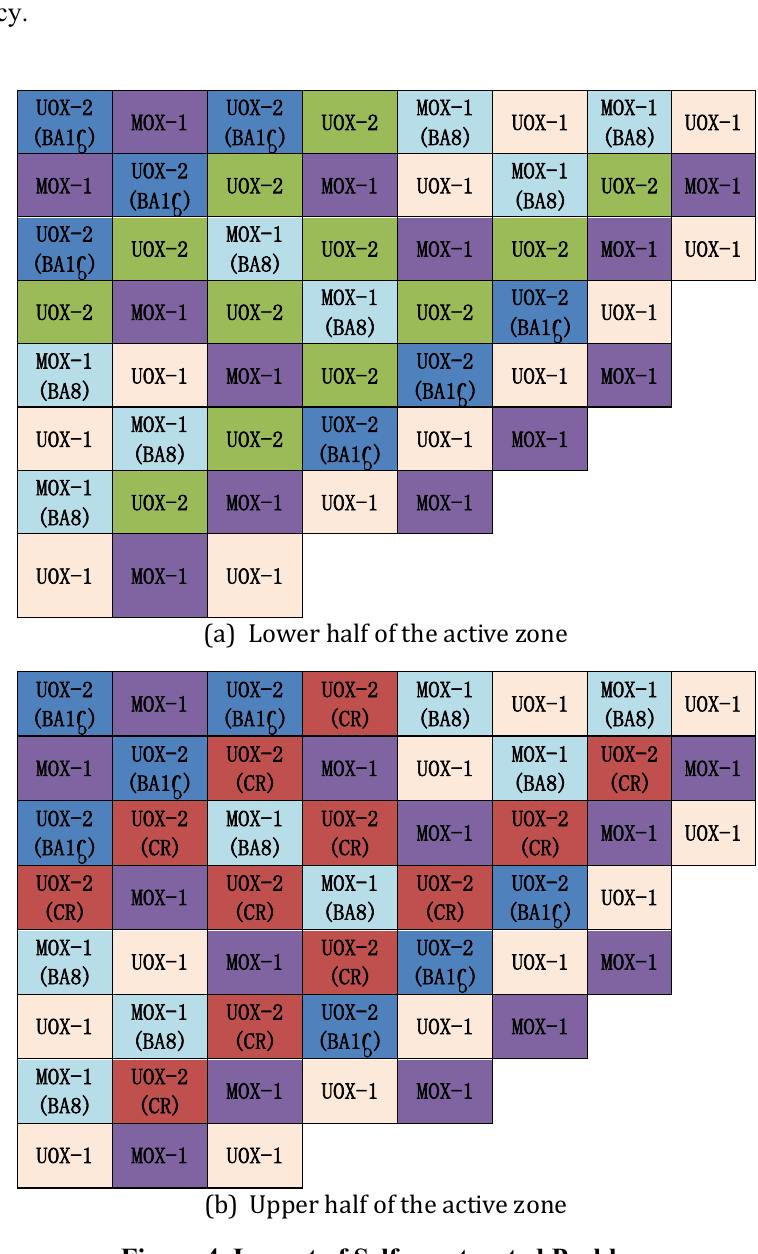
Figure 4. Layout of Self-constructed Problem Table III. Keff Comparison of Self-constructed